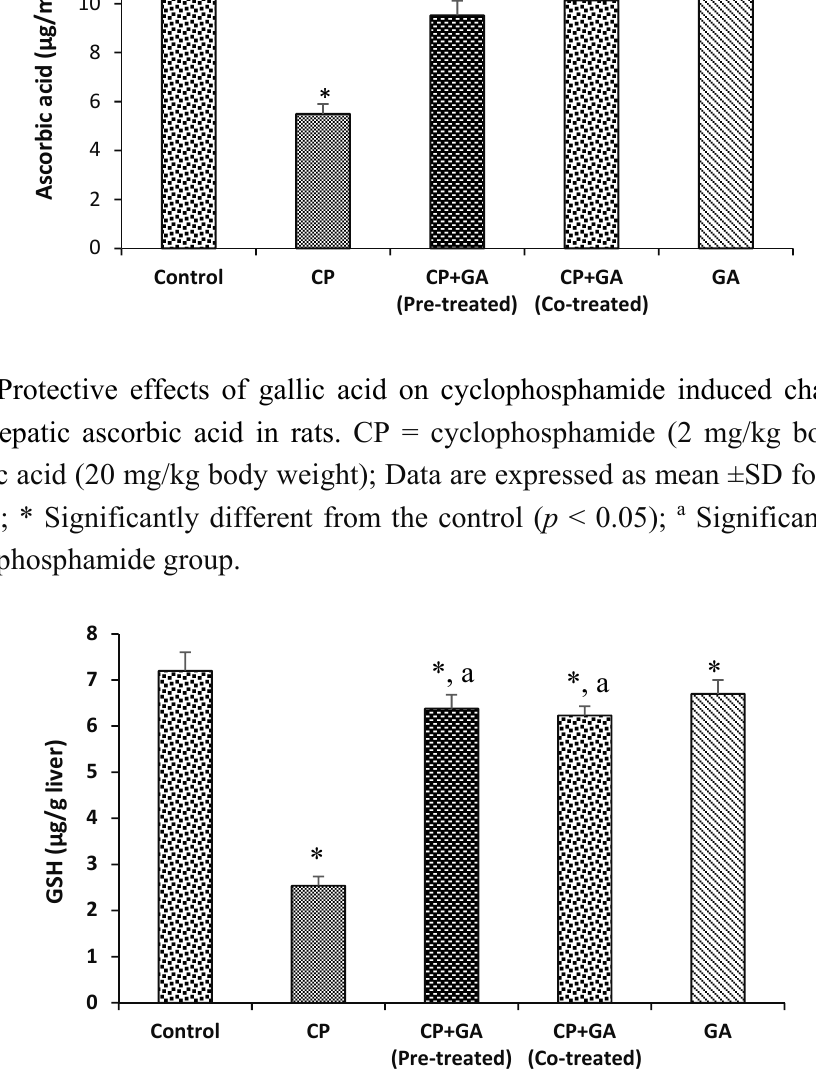
Figure 4. Protective effects of gallic acid on cyclophosphamide induced changes in the levels of hepatic reduced glutathione (GSH) concentration in rats. CP = cyclophosphamide (2 mg/kg body weight); GA = gallic acid (20 mg/kg body weight); Data are expressed as mean ±SD for five rats in each group; * Significantly different from the control ( p < 0.05); a Significantly different from cyclophosphamide